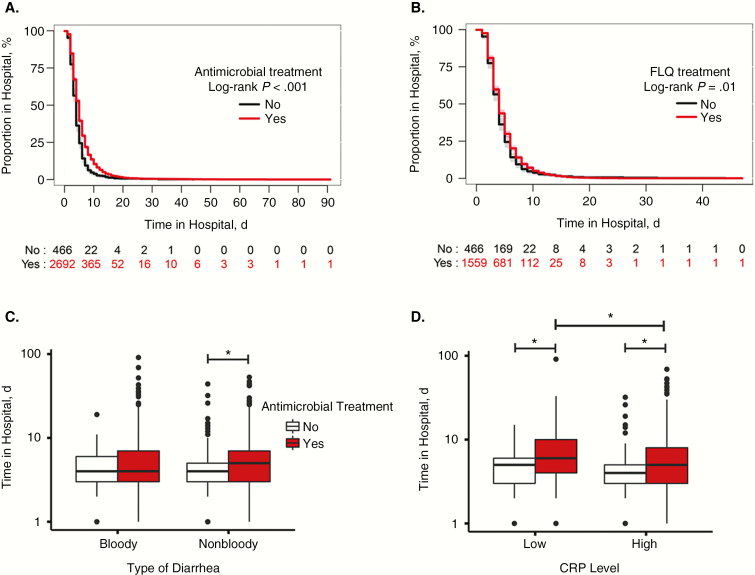
Effect of antimicrobial treatment on clinical outcome. A, B, Kaplan-Meier curves show days in the hospital for diarrheal children treated with antimicrobials (A) or specifically, fluoroquinolones (FLQs) (B). C, D, Effect of antimicrobial usage on the length of hospital stay by different diarrheal types (C) and blood C-reactive protein (CRP) concentration (5 mg/L cutoff) (D). Statistical comparisons for categorical variables were conducted using the Kruskal-Wallis test, where *.05 < P < .01, and *** P < .001. Log-rank tests were used to compare Kaplan-Meier curves for length of hospital stay between groups.